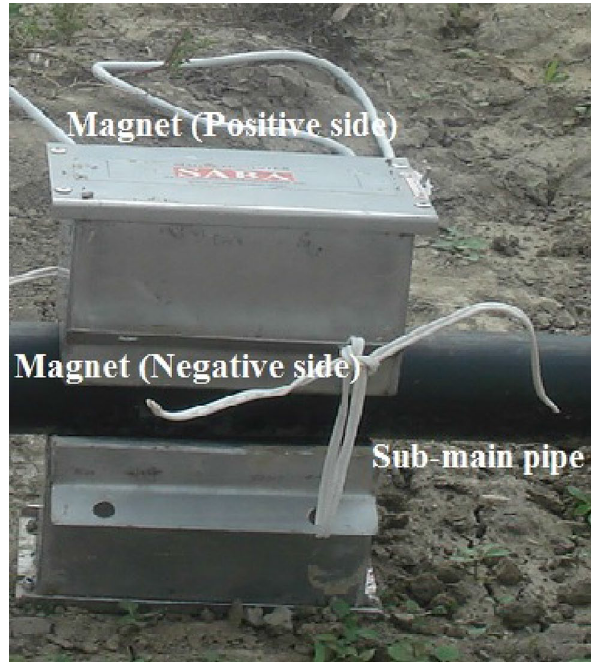
Fig. 2 Magnetic device with two permanent magnets showing their north and south